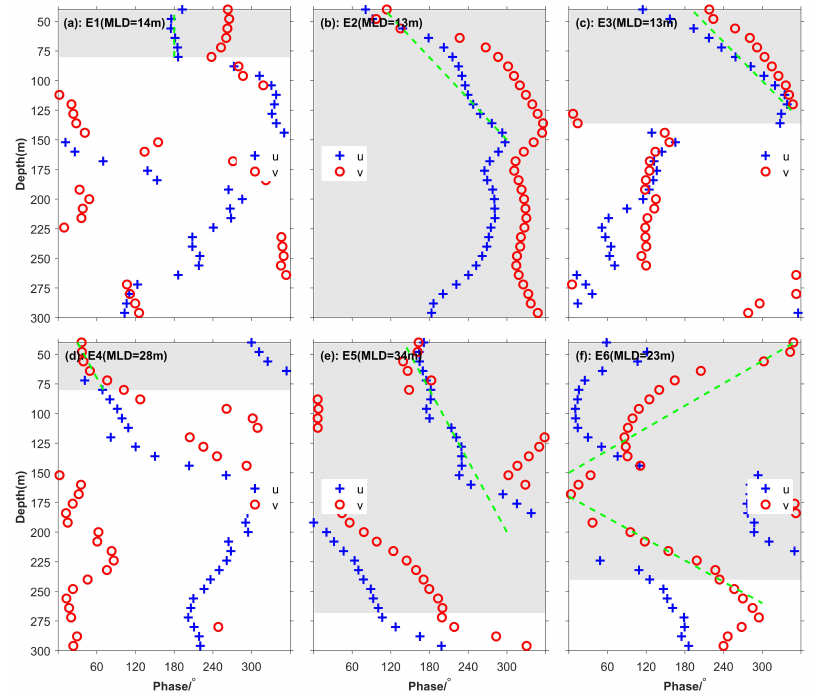
Figure 12. Vertical profiles of phase of the NIWs obtained by the plane wave fitting method. Fig- ures ( a – f ) correspond to episodes 1 to 6, and the blue plus signs and the red circles represent the phase of the zonal and meridional near-inertial currents. The dashed green lines denote the slope of the phase and are utilized to estimate the vertical phase speed. The temporal-mean mixed layer depth during episodes 1 to 6 are 14 m, 13 m, 13 m, 28 m, 34 m, and 23